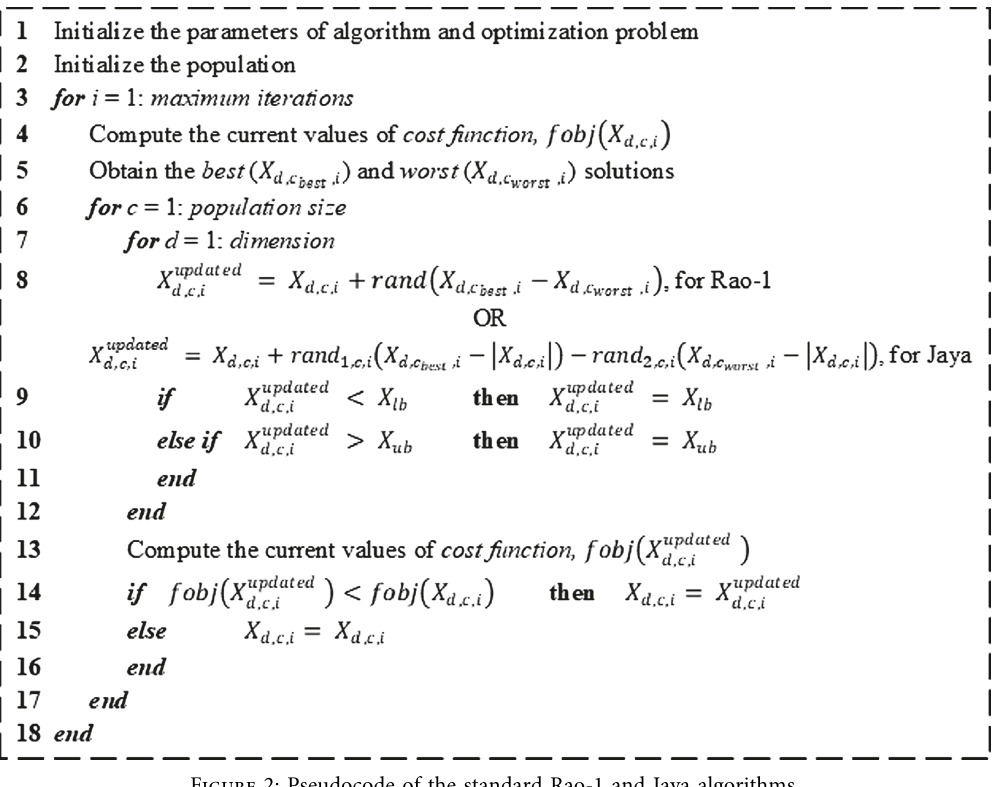
Figure 2: Pseudocode of the standard Rao-1 and Jaya algorithms.